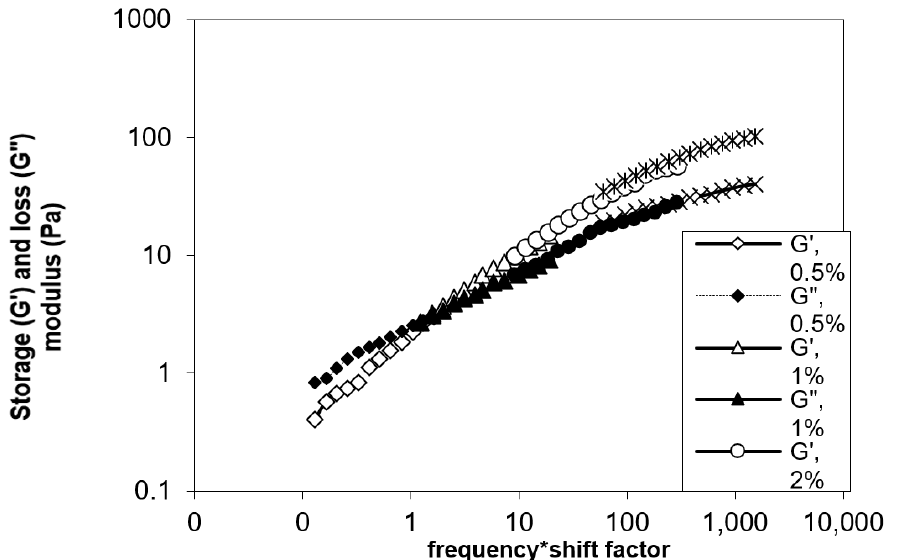
Figure 8. Master curve of storage (G′) and loss (G″) modulus as a function of frequency for Yanang gum at different concentrations.